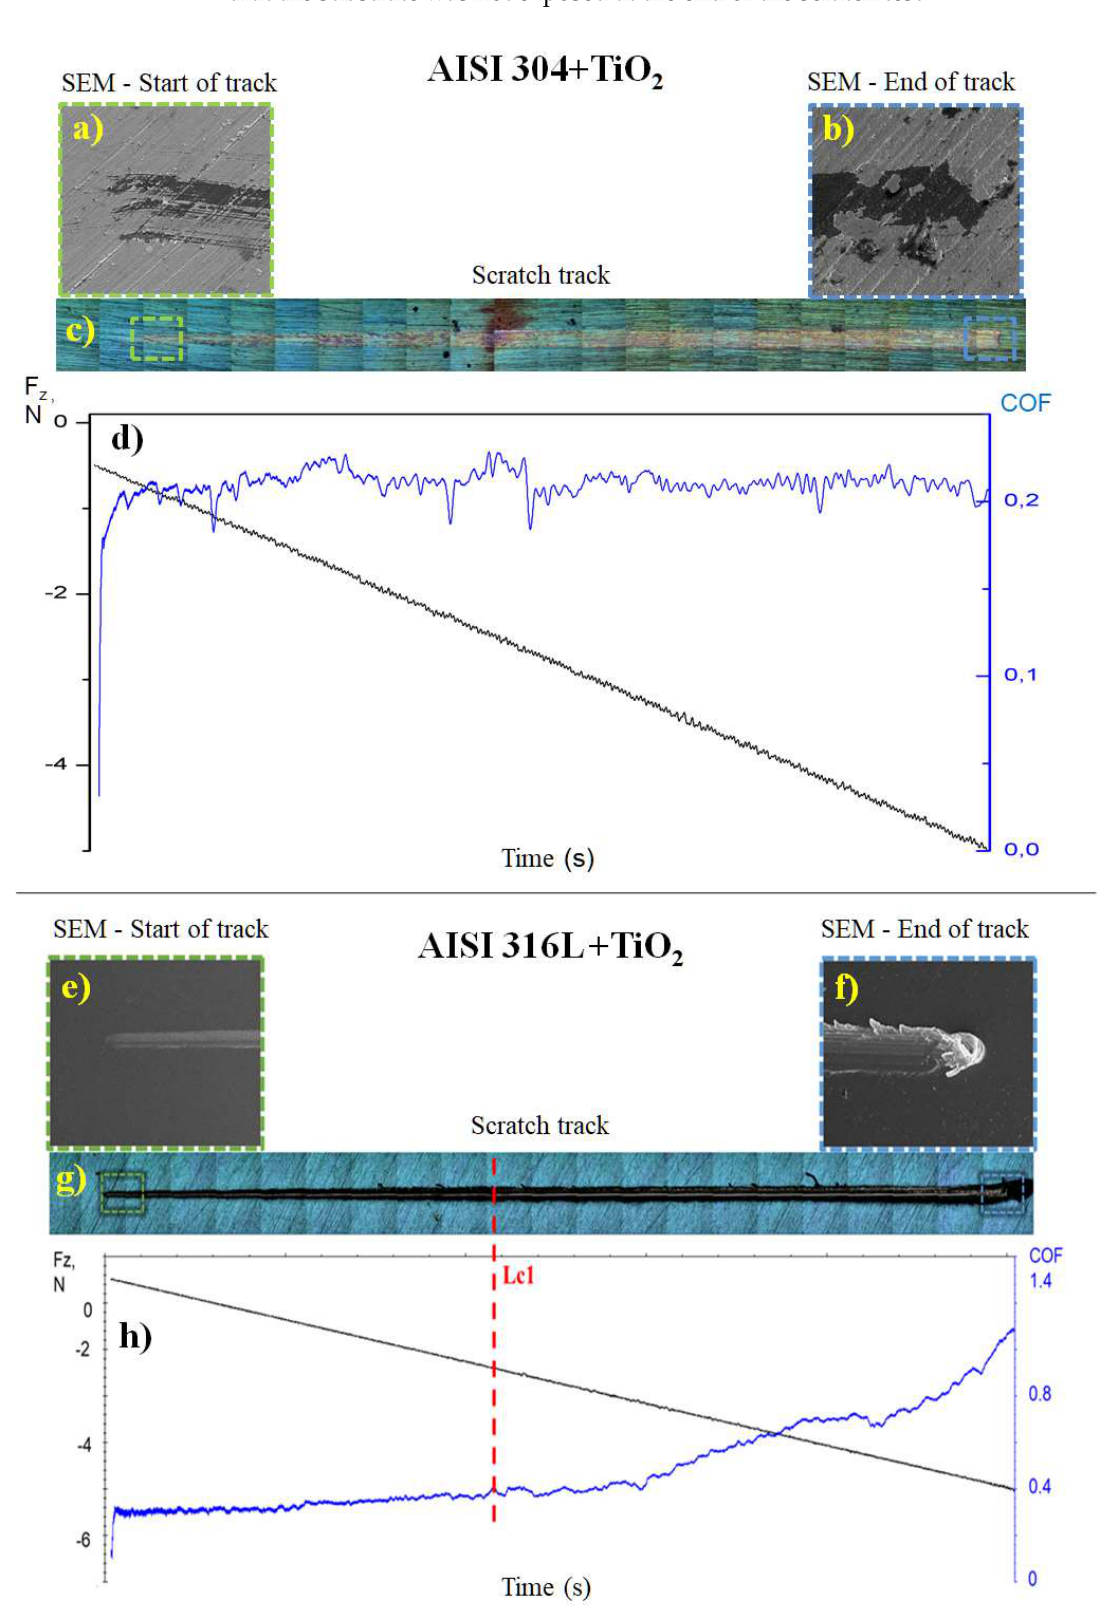
Figure 8. Scratch test results show the friction coefficient (COF) values for the TiO 2 films